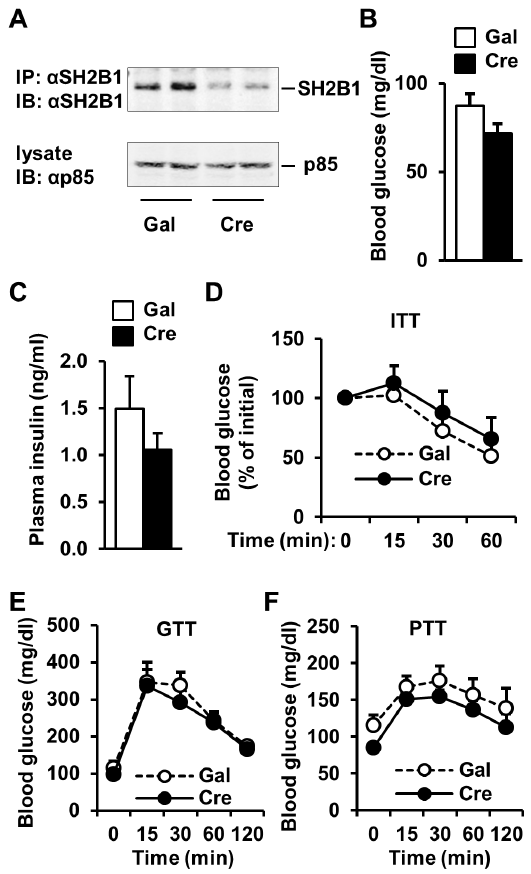
Figure 4. Adult-onset deletion of liver SH2B1 does not exacerbate HFD-induced insulin resistance and glucose intol- erance. (A) Tissue extracts were prepared from male mice (7 weeks of age) 7 days after adenoviral infection. Tissue extracts were immuno- precipitated (IP) and immunoblotted (IB) with anti-SH2B1 antibody (upper panel). Tissue extracts were also immunoblotted with anti-p85 antibody (lower panel). (B-E) SH2B1 f/f male mice (7 weeks of age) were fed a HFD for 5 weeks and infected with b -gal (n=7) or Cre adenoviruses (n=6) via tail vein injection. (B-C) Overnight fasting blood glucose (B) and plasma insulin levels (C) 10 days after adenoviral infection. (D) ITT (13 days after adenoviral infection). (E) GTT (16 days after adenoviral infection). (F) PTT (19 days after adenoviral